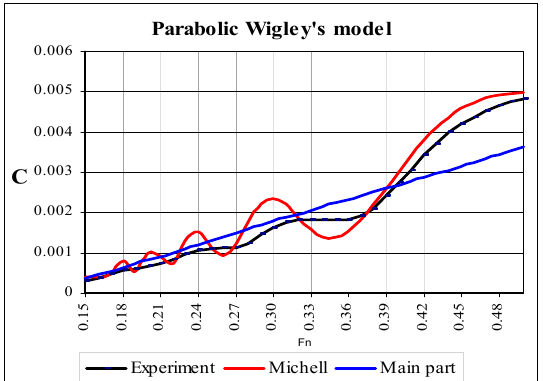
Figure 1. Calculated Michell’s curve (red) and its main part (blue) passes above the residual resistance curve (black)